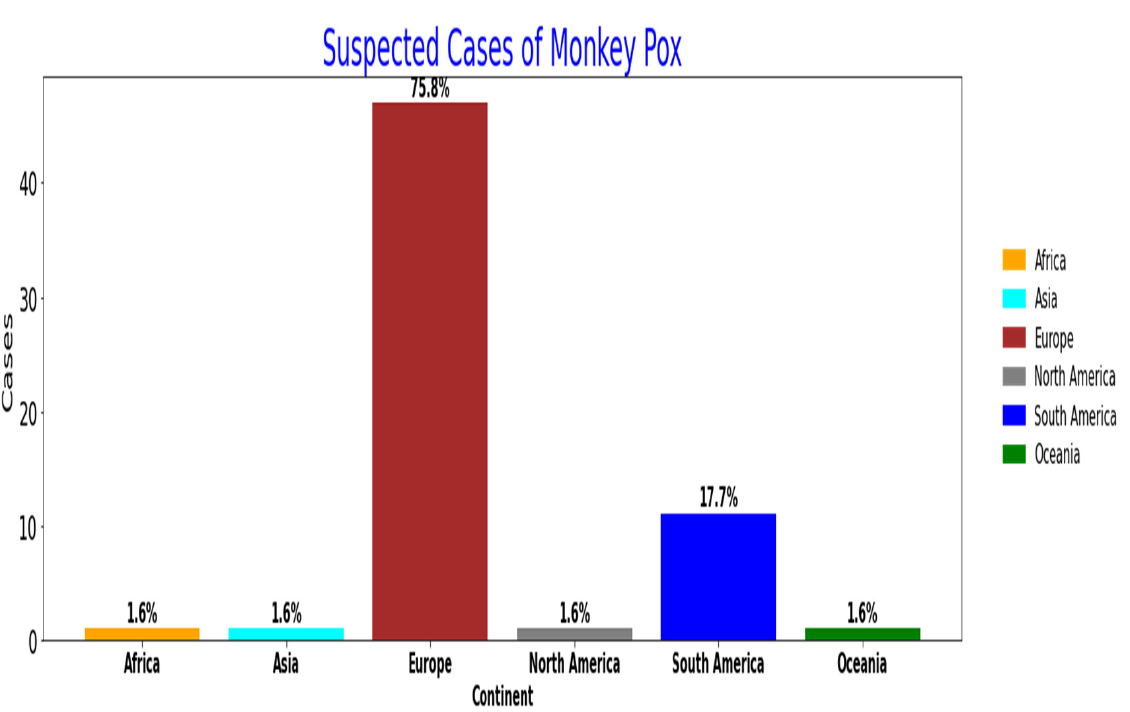
Figure 4. Suspected Cases of Monkey Pox.